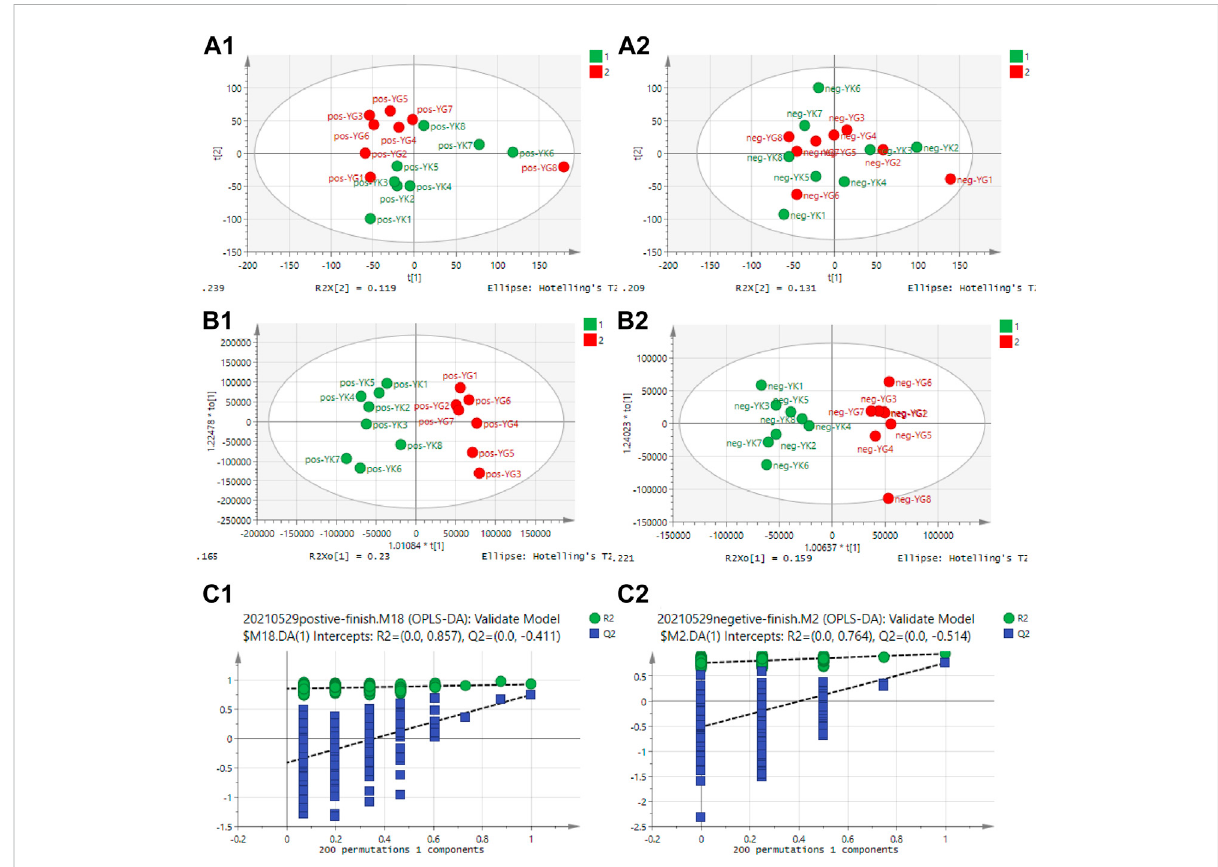
FIGURE 7 Results of multivariate data analysis for rats in YIN-K and YIN-G groups. Note: (A1) PCA scores plot-ESI + ; (A2) PCA scores plot-ESI − ; (B1) OPLS- DA scores plot-ESI + ; (B2) OPLS-DAscores plot-ESI − ; (C1) Permutation plot-ESI + ; (C2) Permutation-scores plot-ESI −